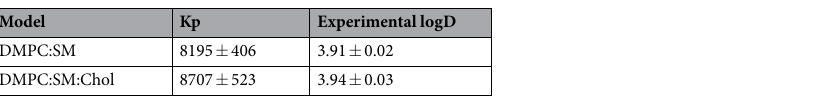
Table 1. Partition Coefficients (expressed as Kp and logD) of doxorubicin in DMPC:SM [8:2] and DMPC:SM:Chol [7:1.5:1.5] at pH 7.4 and 37 °C a . a All values represent the mean ± standard deviation (n = 3). * p < 0.05 statistically different from the other